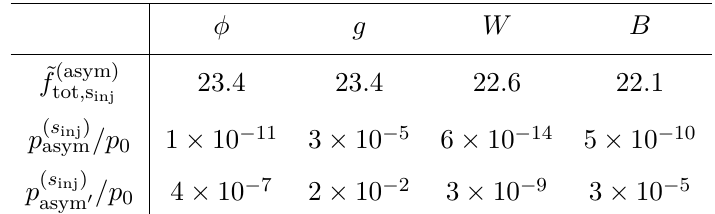
, respectively. asym 0